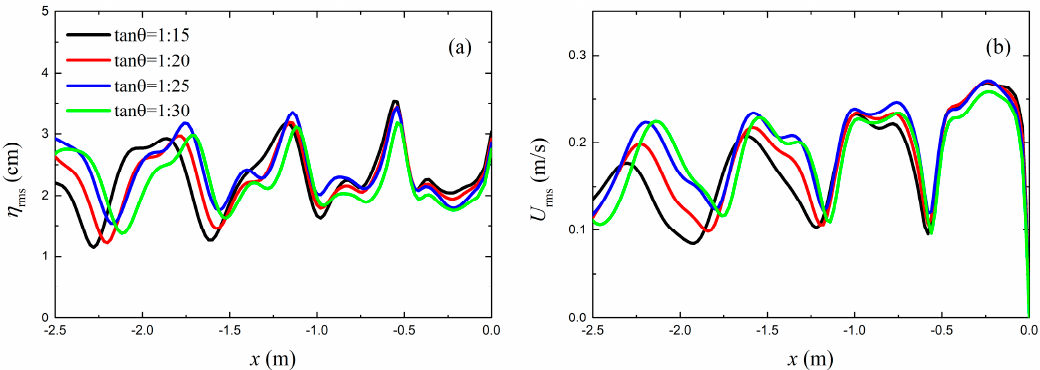
Figure 12. Computed spatial distributions of ( a ) η rms and ( b ) U rms near the seawall for Cases 7–10.